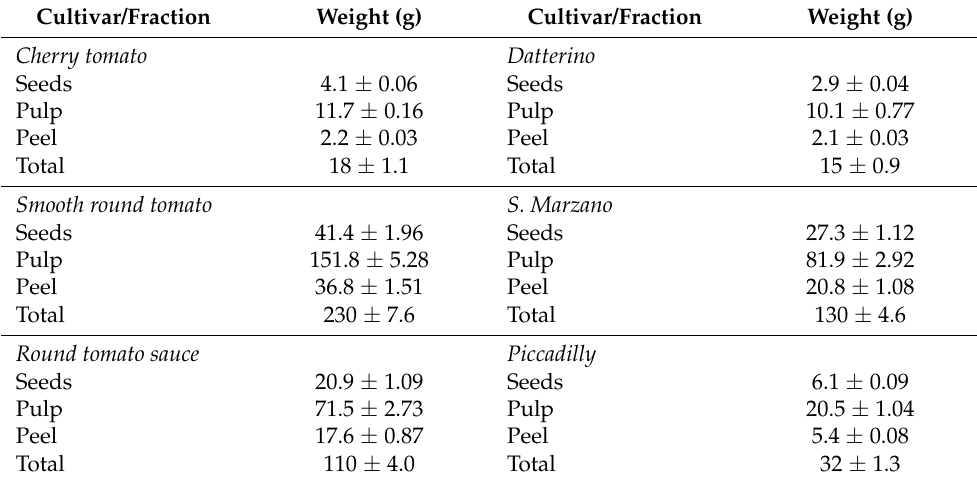
Table 1. Weight of the seed, pulp, and peel fractions of six cultivars of tomatoes (means ± standard deviation, n = 3). Cultivar/Fraction Weight (g) Cultivar/Fraction Weight (g)